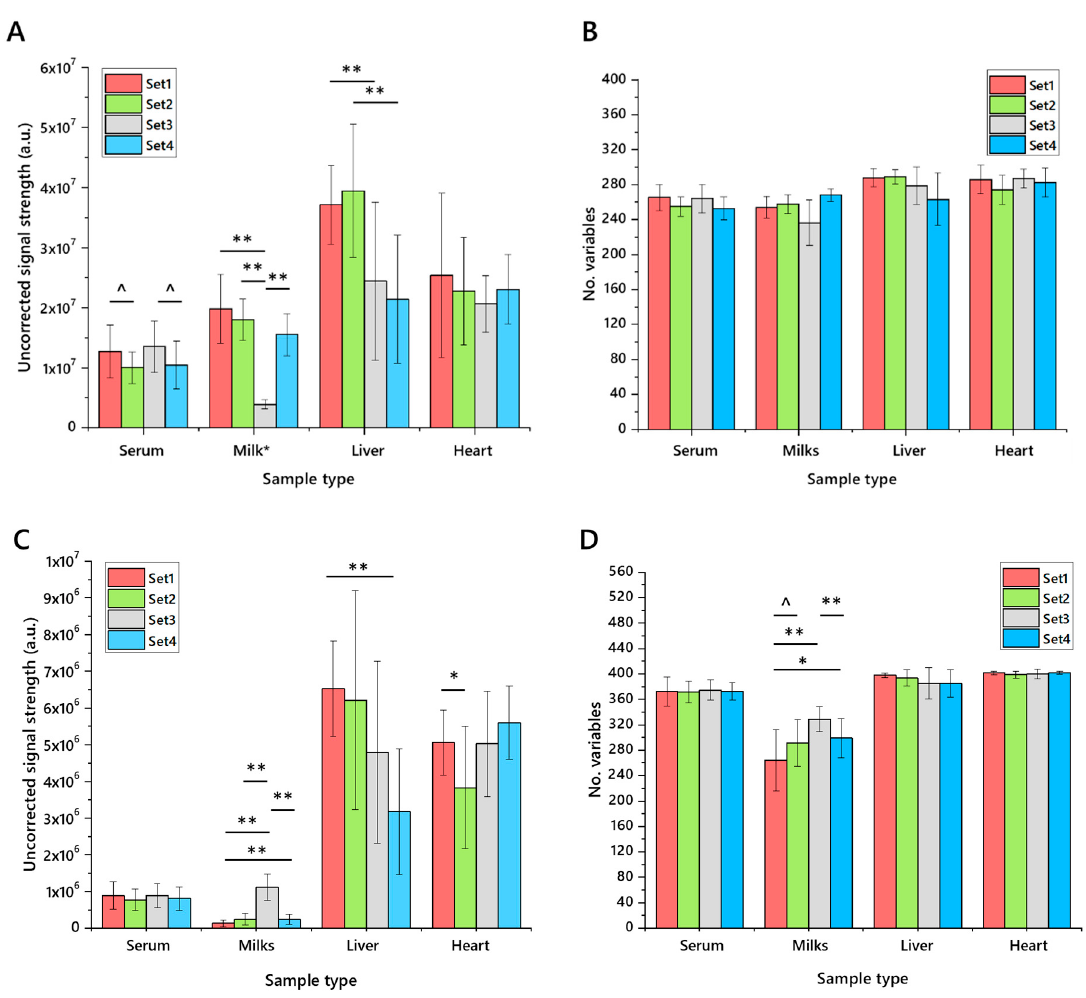
Figure 4. The uncorrected signal strength and number of variables detected in lipid extracts from four different matrices using four different extraction methods for high-throughput lipidomics ( n = 20 measurements of each). Panel A , total signal strength in positive ionisation mode; B , number of variables identified in positive mode; C , total signal strength in negative ionisation mode; D , number of variables identified in negative mode. Error bars show standard deviation. Extractions were performed using DMT, dichloromethane/methanol/triethylammonium chloride 3:1:0·005 with an aqueous wash. Samples: Serum, human blood serum; Milk (set1, unhomogenised Jersey milk; set2, whole caprine milk; set3, soya drink; set4, whole, homogenised bovine milk); heart, murine heart homogenate; liver, mouse liver homogenate. Murine heart and liver samples were drawn from two pools of two feeding phenotypes. Milk sample values were scaled (reduced by an order of magnitude) to fit. ^ p < 0·05; * p < 0·01; ** p < 0·001. Table 1. Variables stratified by parameters for chemical structures. The proportion (%) of variables in strata of variance for each of four matrices. Coefficient of variance calculated from the standard deviation of 16-20 samples of each of four groups, divided by the mean for the same group. Milk samples and human serum were drawn from four different commercial sources (Milk1, un- homogenised Jersey milk; Milk2, whole caprine milk; Milk3, soya ( Glycine max ) drink; Milk4, whole, homogenised bovine milk). Murine heart and liver samples were drawn from two pools of two feeding phenotypes.